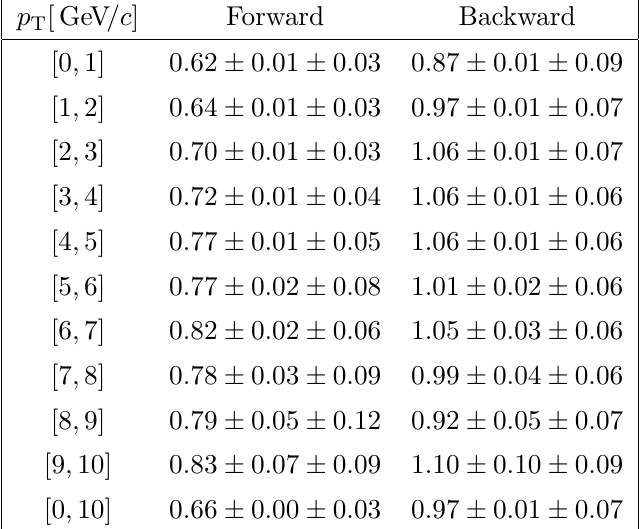
Table 5 . Nuclear modi(cid:12)cation factor R p Pb for prompt D 0 meson production in di(cid:11)erent p T ranges, integrated over the common rapidity range 2 : 5 < j y (cid:3) j < 4 : 0 for p T < 6 GeV =c and over 2 : 5 < j y (cid:3) j < 3 : 5 for 6 < p T < 10 GeV =c for the forward (positive y (cid:3) ) and backward (negative y (cid:3) ) samples. The